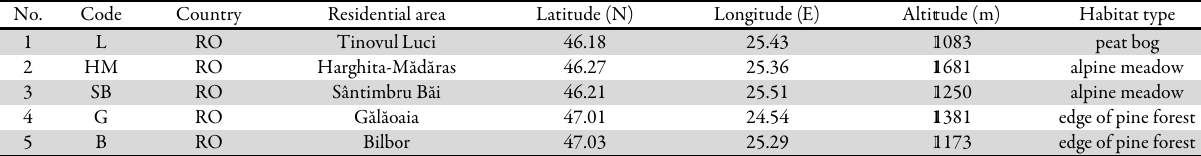
Table 1. List of Vaccinium vitis